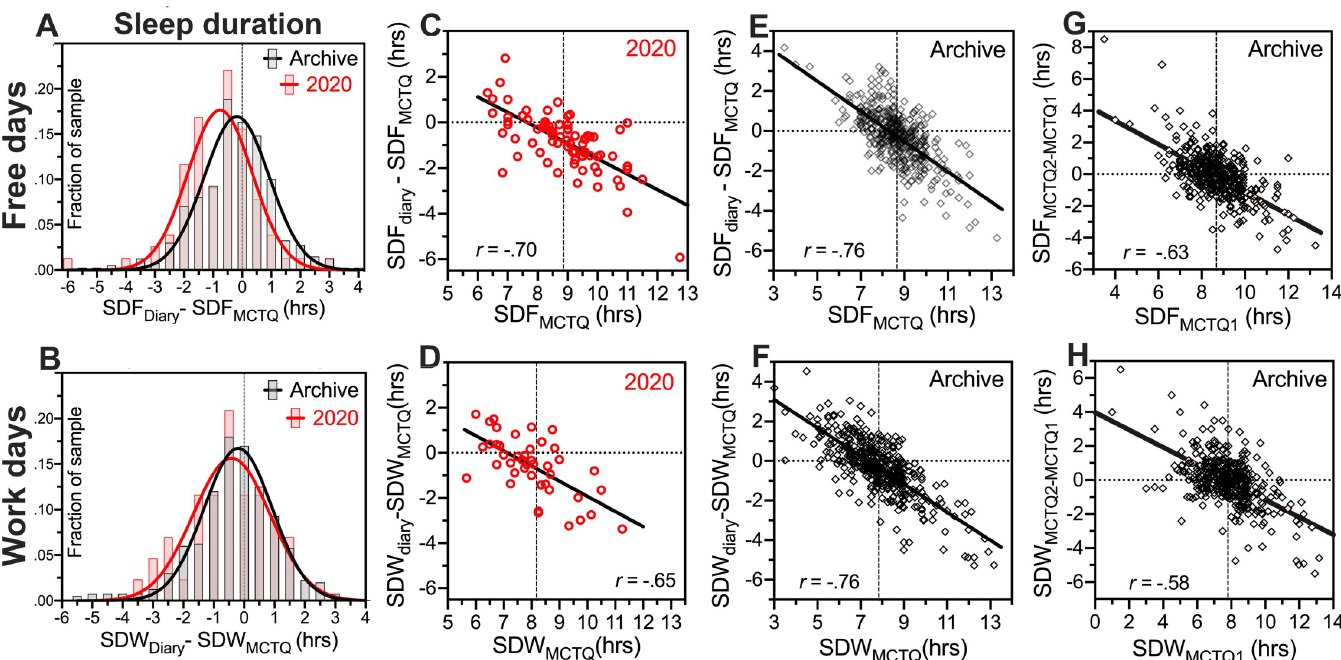
Fig 5. Differences in nocturnal sleep duration (SD) as measured by sleep diaries and Munich Chronotype Questionnaire (MSTQ) for free days (SDF diary , SDF MCTQ ) and work days (SDW diary , SDW MCTQ ). [A,B]. Frequency distributions and gaussian curve fits of signed differences between SDF diary and SDF MCTQ (A) and SDW diary and SDW MCTQ (B). [C-H]. Bivariate scatterplots, with Pearson r correlation coefficients and best fitting linear regression lines. [C,D]. Relationship between SD MCTQ and the signed difference between SD diary and SD MCTQ for work days (C; N = 43 pairs) and free days (D; N = 78) in the 2020 group. [E,F]. Relationship between SD MCTQ and the signed difference between SD diary and SD MCTQ for work (E; N = 400) and free days (F; N = 398) in the archive group. [G,H]. Relationship between SD measured by MCTQ early in the semester (SD MCTQ1 ) with the difference between SD MCTQ1 and SD measured by MCTQ a second time, late in the semester (SD MCTQ2 ) for free days (G; N = 402) and work days (H; N = 388) in the archive group. r denotes Pearson correlation coefficient. Regression lines fit by linear least